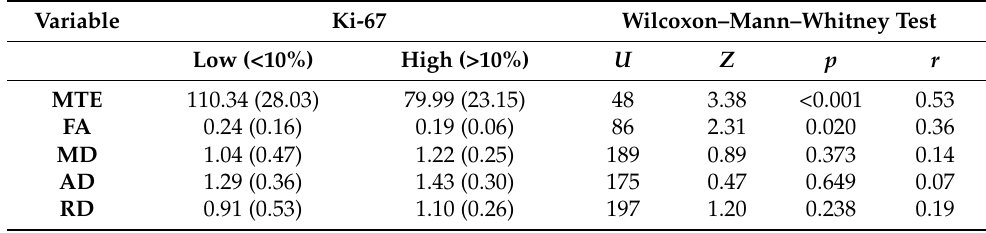
Table 3. Univariate analysis of Ki-67 groups.